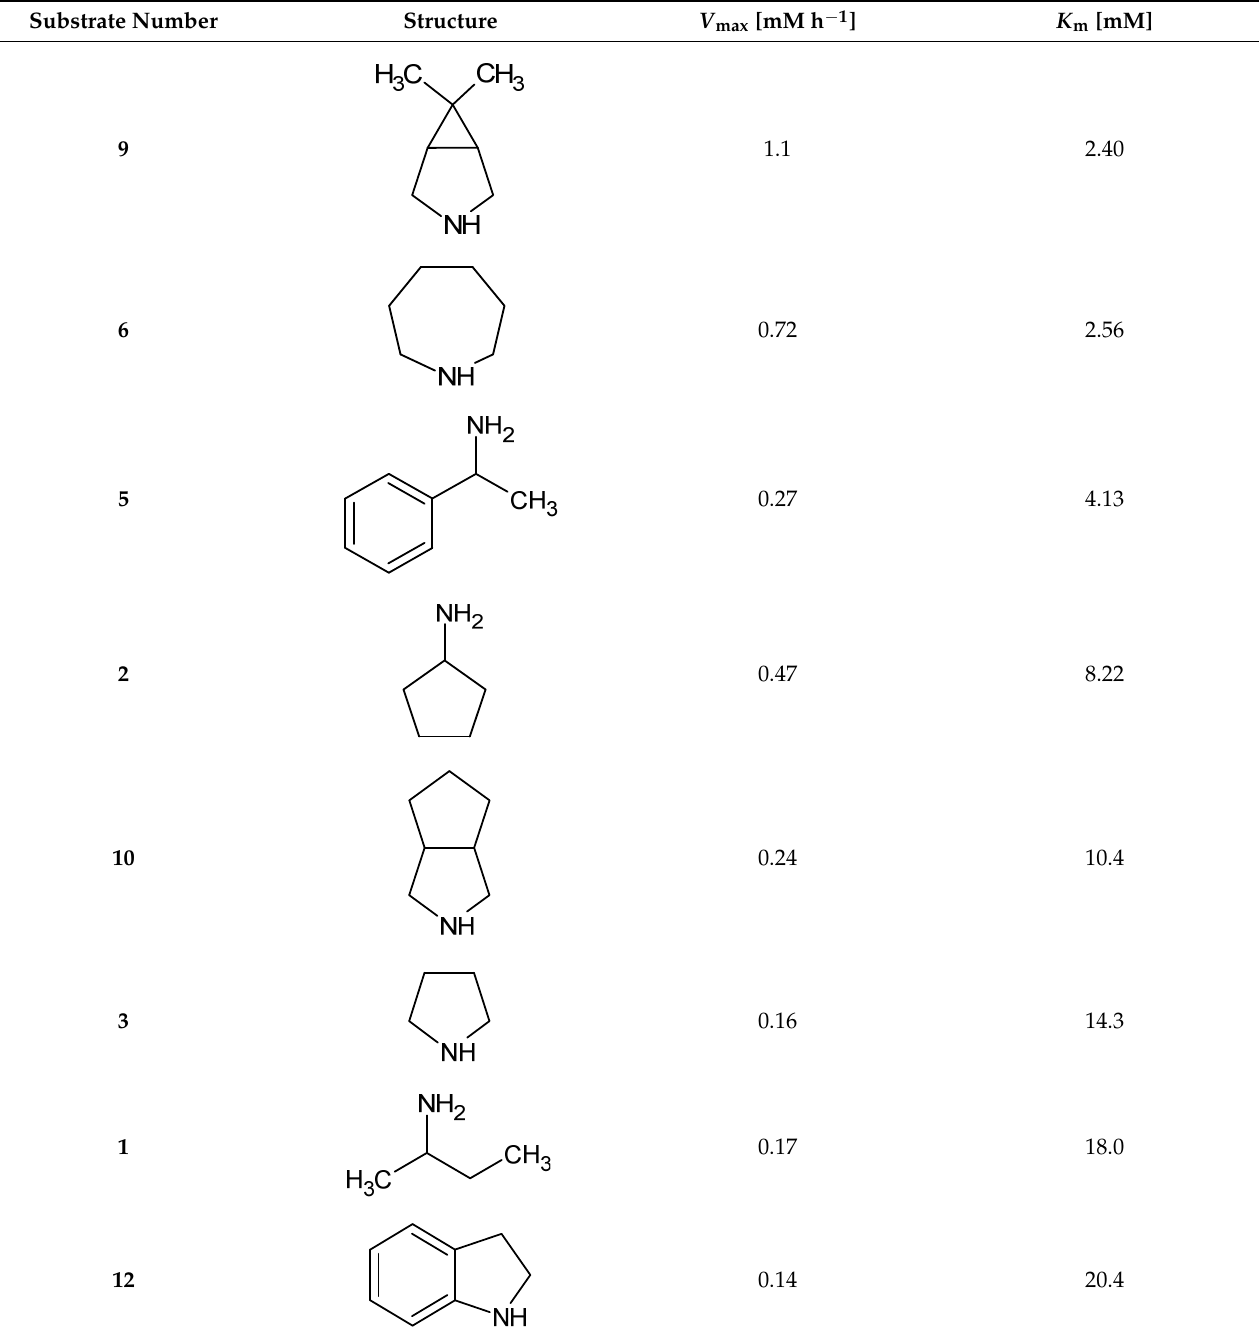
Table 3. Substrate specificity of MAO P3 towards various amines. All substrates were dissolved in 0.1 M of potassium phosphate buffer pH 7.2 and MAO P3 was used in the assay at 1 U/mL. The V max and K m values were counted based on the Beer-Lambert curve. The substrates were arranged from the highest to the lowest affinity of the enzyme towards the substrate.